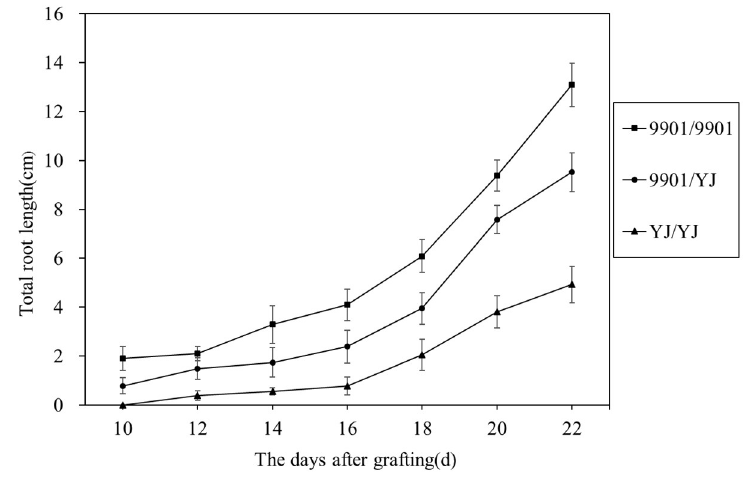
Figure 2. The total root length of willow grafts in hydroponic culture.